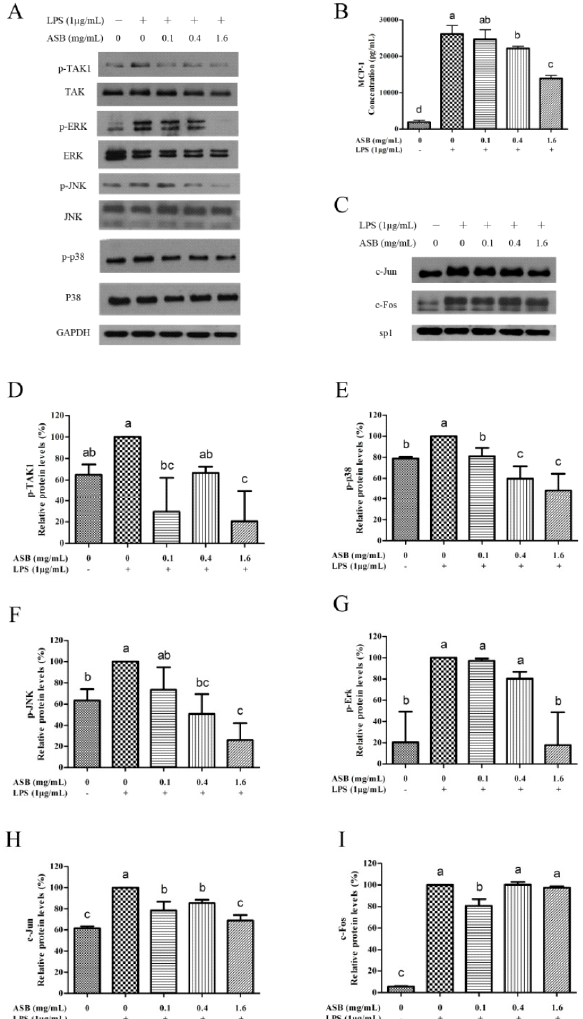
Figure 6. E ff ects of ASB on the phosphorylation of protein levels on AP-1 pathways in LPS-induced Figure 6. Effects of ASB on the phosphorylation of protein levels on AP‐1 pathways in LPS‐induced macrophages ( A ), and relative protein levels of p-TAK1 ( D ), p-p38 ( E ), p-JNK ( F ), and p-Erk ( G ). macrophages ( A ), and relative protein levels of p‐TAK1 ( D ), p‐p38 ( E ), p‐JNK ( F ), and p‐Erk ( G ). Expression levels of nuclear proteins of transcription factors NF- κ B and AP-1 regulated upon ASB Expression levels of nuclear proteins of transcription factors NF‐κB and AP‐1 regulated upon ASB treatment ( C ), and relative protein levels of c-Jun ( H ) and c-Fos ( I ). ( B ) E ff ects of ASB on the secretion treatment ( C ), and relative protein levels of c‐Jun ( H ) and c‐Fos ( I ). ( B ) Effects of ASB on the secretion of MCP-1 in the culture of LPS-induced macrophages. Results were expressed as mean ± SD. Relative protein levels of each column marked by the same letter are not significantly di ff erent. Significance is represented as p <